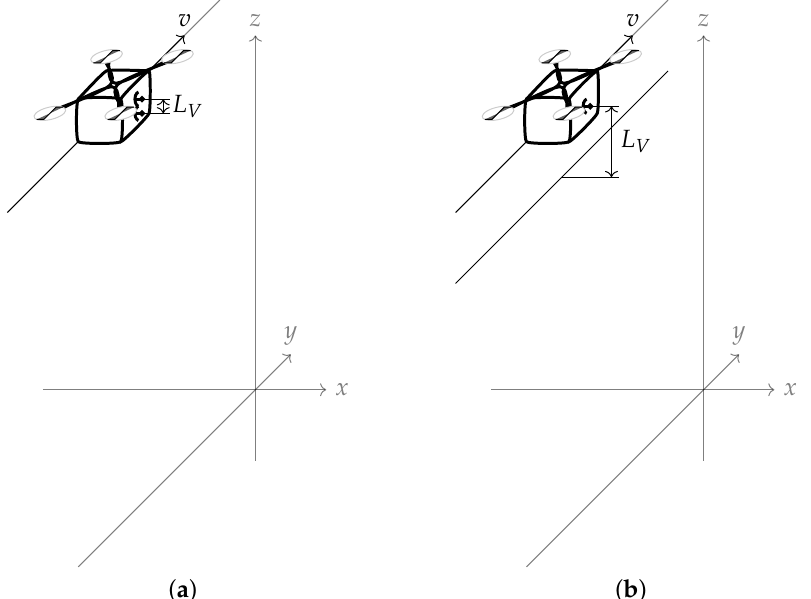
Figure 1. Traditional Interferometric Synthetic Aperture Radar (InSAR) geometries: ( a ) Dual antenna, single pass. ( b ) Single antenna, dual pass. v denotes the direction of motion of the radar platform, L V is the baseline, and x , y , z are Cartesian coordinates .